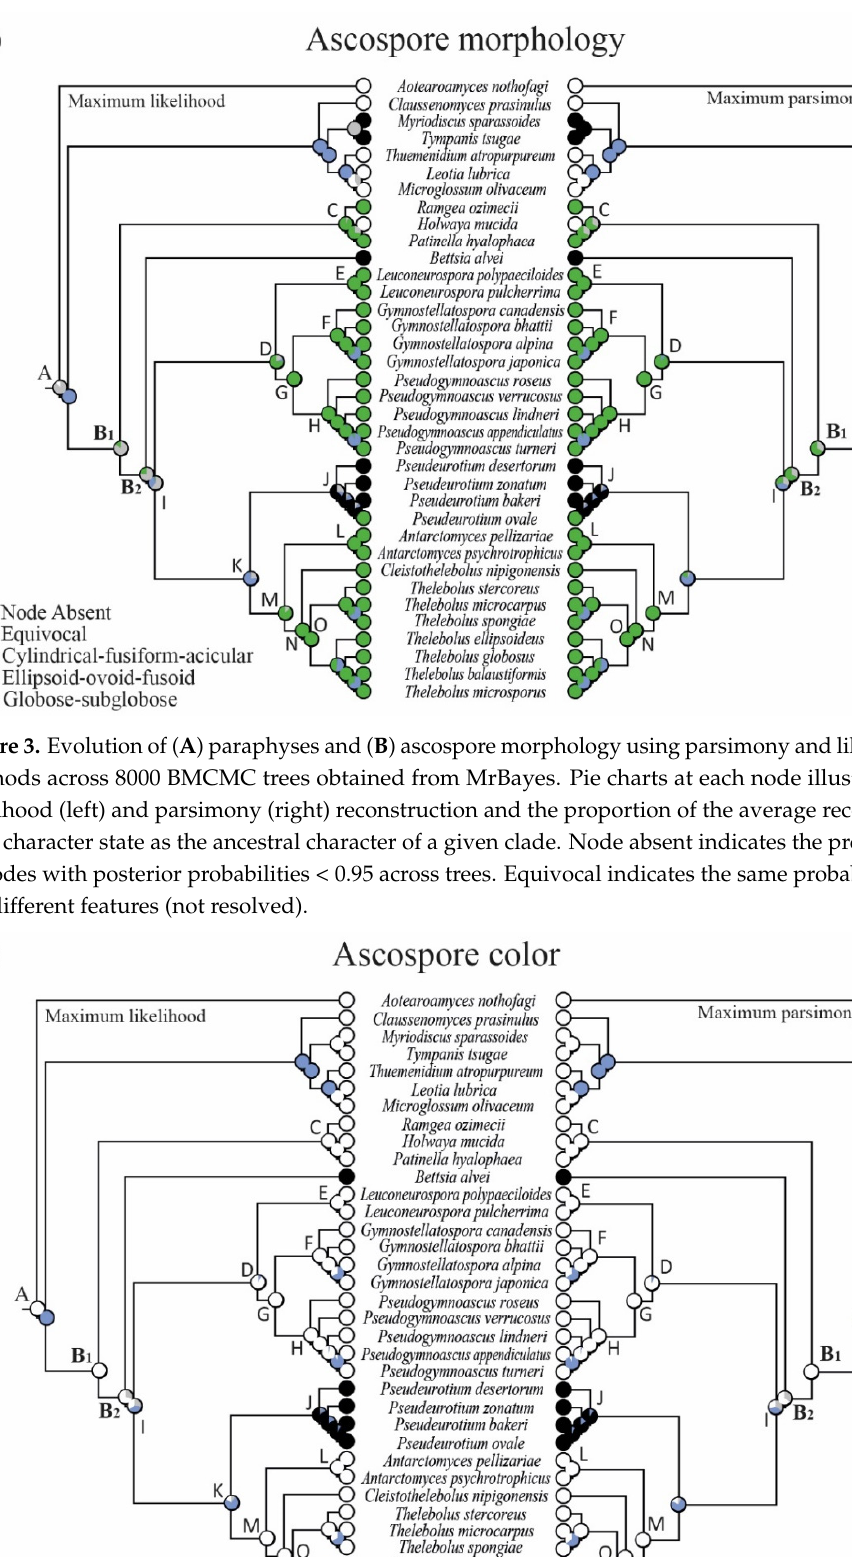
Figure 4. Evolution of ( A ) ascospore color and ( B ) ornamentation using parsimony and likelihood methods across 8000 BMCMC trees obtained from MrBayes. Pie charts at each node illustrate the likelihood (left) and parsimony (right) reconstruction and the proportion of the average received by each character state as the ancestral character of a given clade. Node absent indicates the proportion of nodes with posterior probabilities < 0.95 across trees. Equivocal indicates the same probability for the different features (not resolved).